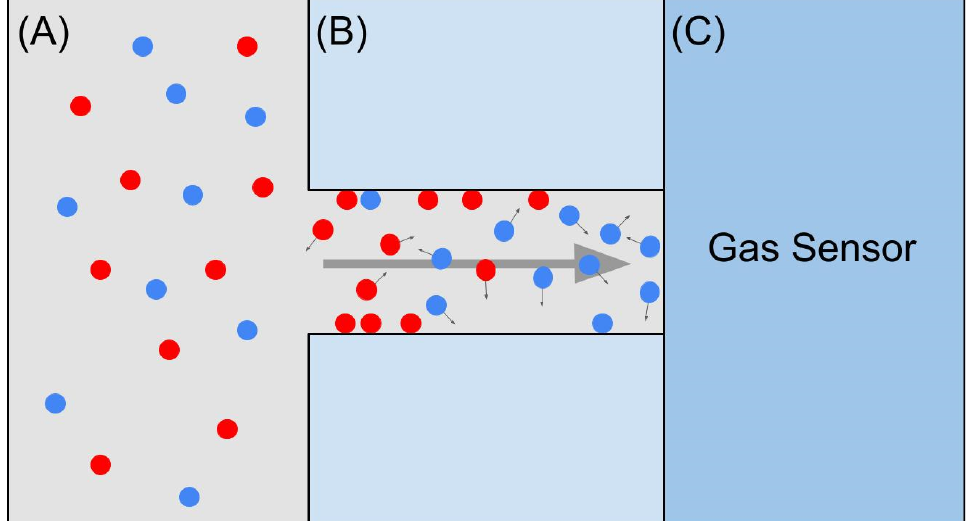
Figure 2. Basic operating principle for microfluidic electronic nose devices. Unlike electronic noses discussed in Section 2, the sensor array has been replaced with a single sensor coupled to a microfluidic channel. ( A ) Headspace sample containing a mixture of so analytes, red and blue. ( B ) Sample flows through microfluidic channel due to diffusion processes. Separation occurs due to adsorption on the channel walls. ( C ) Compound with the lowest retention time (time spent within the channel) will reach the gas sensor. This provides the user with a curve with features specific to the mixture of gases within the sample allowing for discrimination [84].